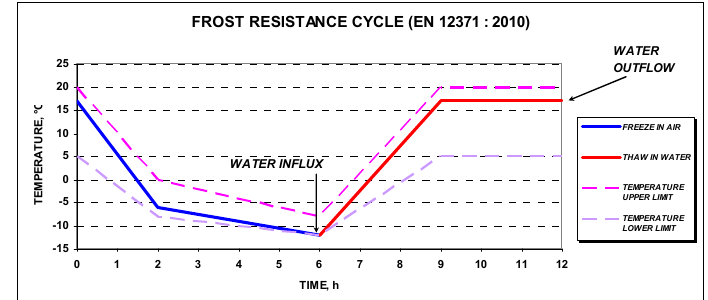
Figure 2. Complete freeze–thaw cycle test.